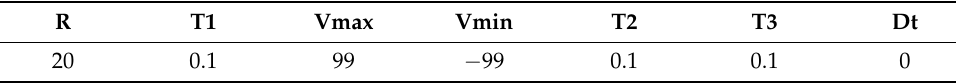
Figure 2. TGOV1 governor turbine model with an external sinusoidal signal. Table 1. TGOV1 governor parameter.